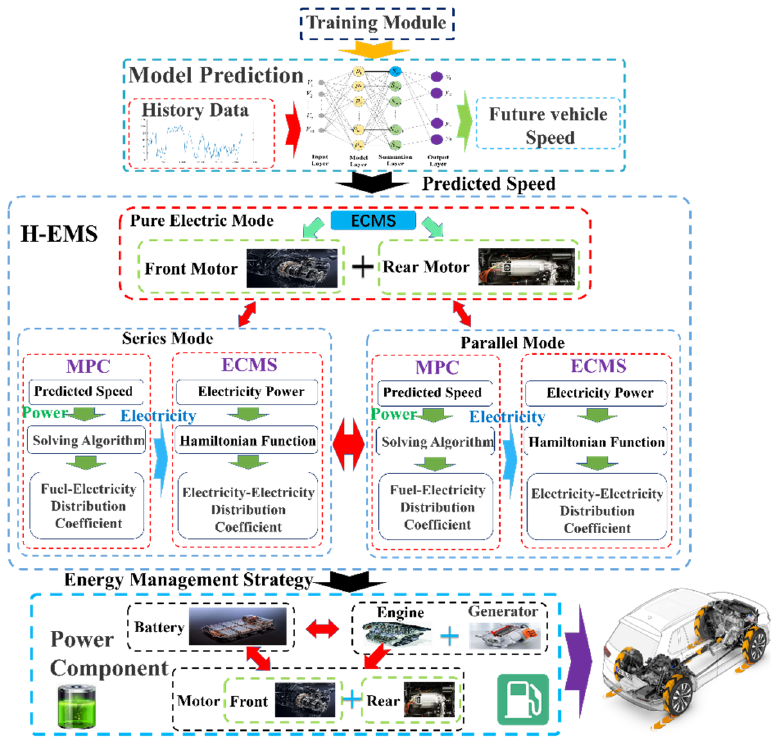
Figure 5. The illustration of the energy management strategy